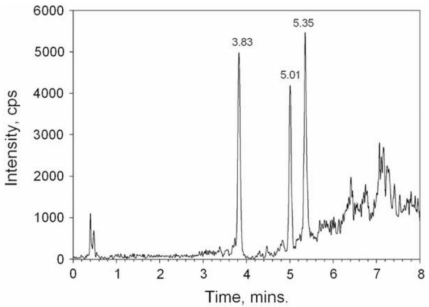
Total ion chromatogram for a fish sample extract containing P-CTX-1 (3.83 min, 0.8 mg/kg), P-CTX-2 (5.01 min, 1.1 mg/kg) and P-CTX-3 (5.35 min, 1.4 mg/kg). Reprinted from [125], reprinted with permission from Elsevier.